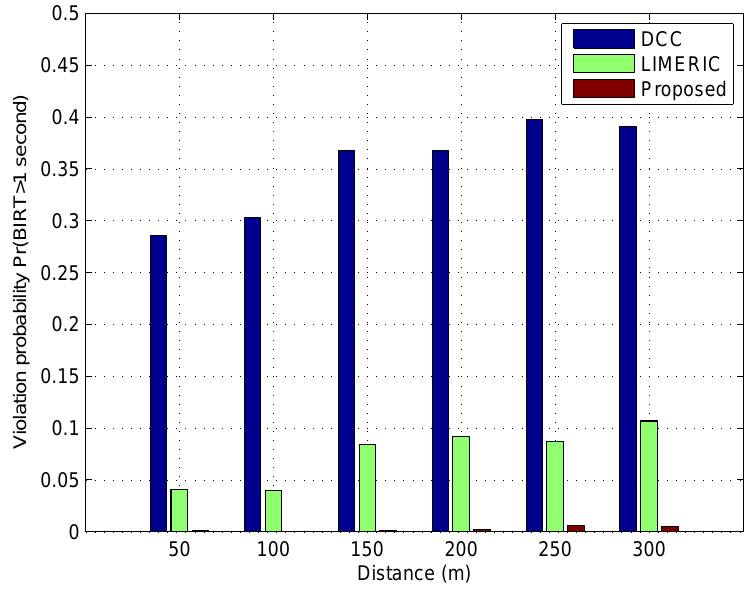
Figure 6. Violation probability of